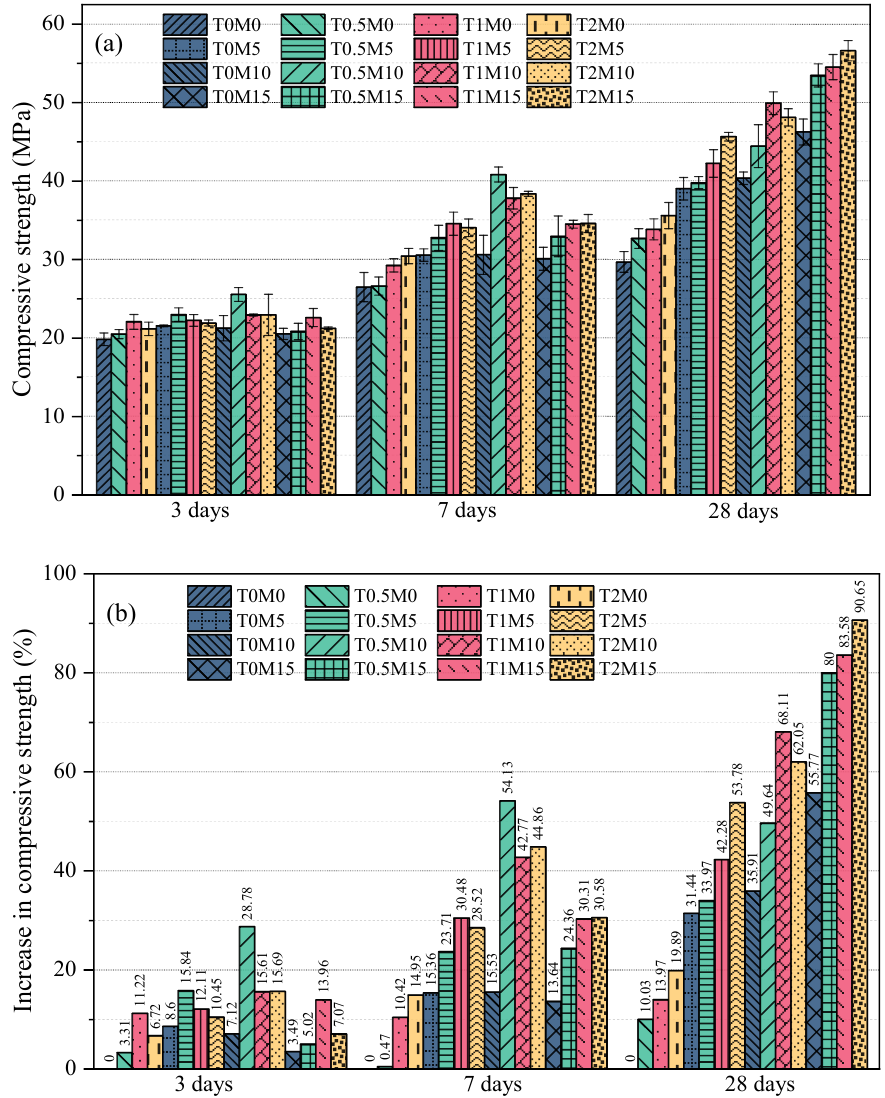
Figure 4. The compressive strength improvement by black tea extract and metakaolin: ( a ) the compressive strength; ( b ) the increasing percentage.